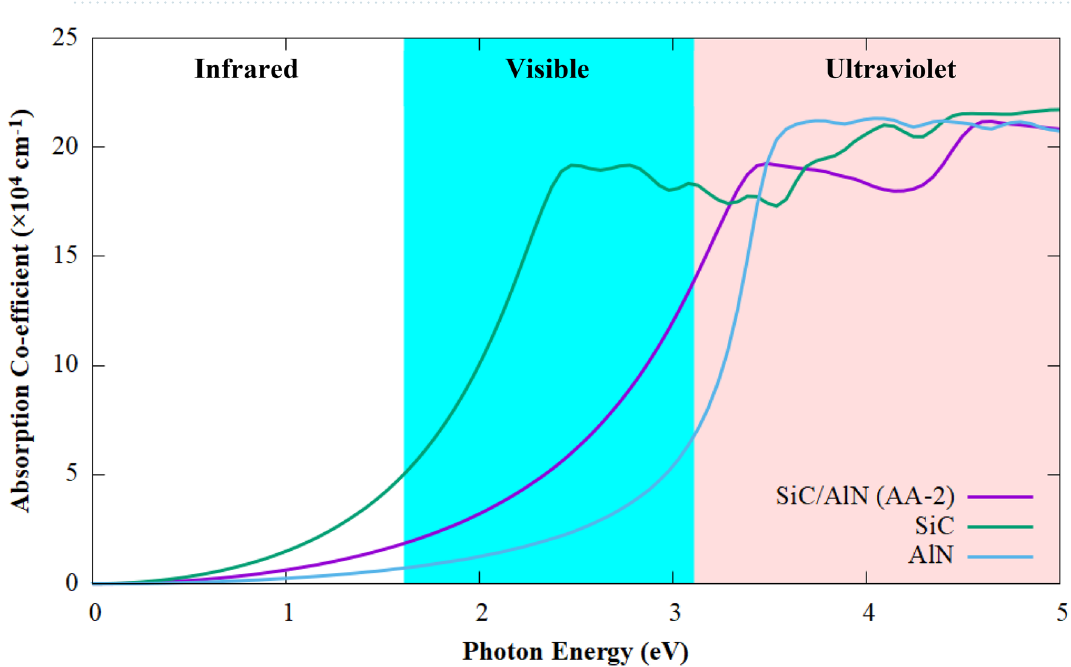
Figure 8. Optical absorption spectra of the SiC/AlN van der Waals heterostructure (AA-2 configuration) along with that of the free-standing SiC monolayer and the AlN